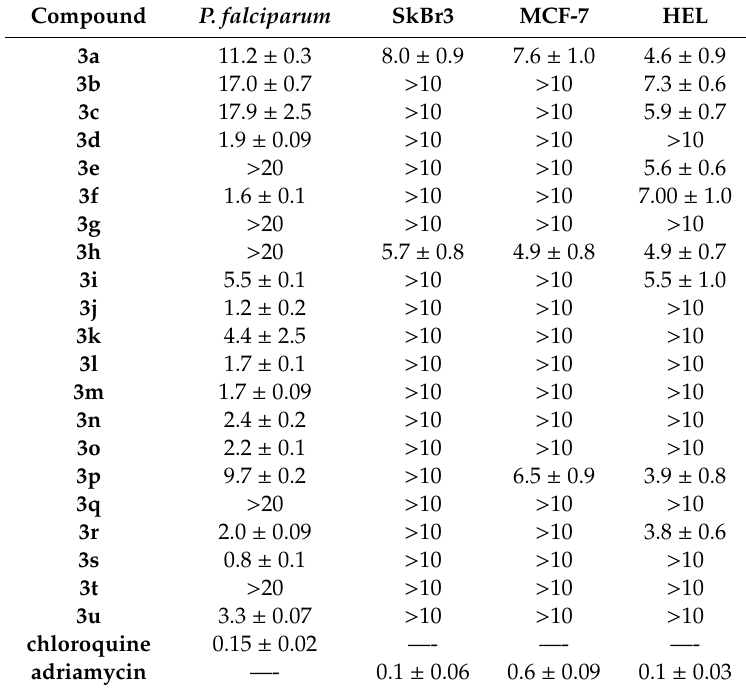
Table 2. In vitro activity of compounds ( 3a – 3u ) against Plasmodium falciparum F32 Tanzania (IC 50 µ M) and against SkBr3 (human breast cancer), MCF-7 (human breast adenocarcinoma), and HEL (human erythroleukemia) cell lines (IC 50 µ